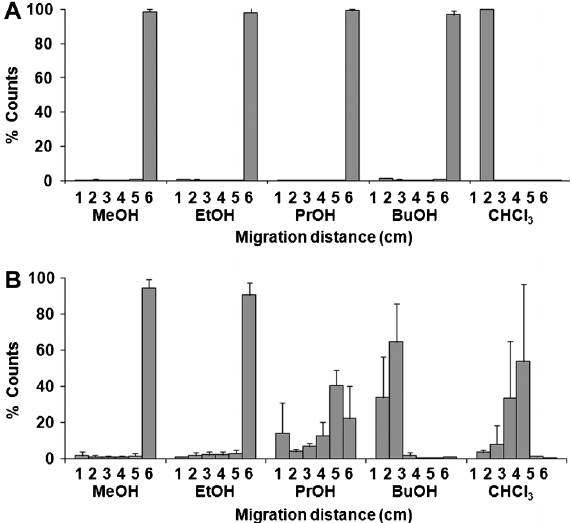
Figure 1. Paper chromatography of 99m TcO 4– ( A ) and [ 99m Tc(MIBI) 6 ] + ( B ) reported as percent of counts in segments of the chromatographic strip (cm), numbers 1 to 6. Alcohols (MeOH: methanol, EtOH: ethanol, PrOH: 1-propanol, BuOH: 1- butanol) or chloroform (CHCl 3 ) were used as the mobile phase, and Whatman 1 (W1) paper as the stationary phase [a similar behavior was obtained with Whatman 3MM (W3MM) paper, data not shown]. Data are reported as means±SD for n=3.